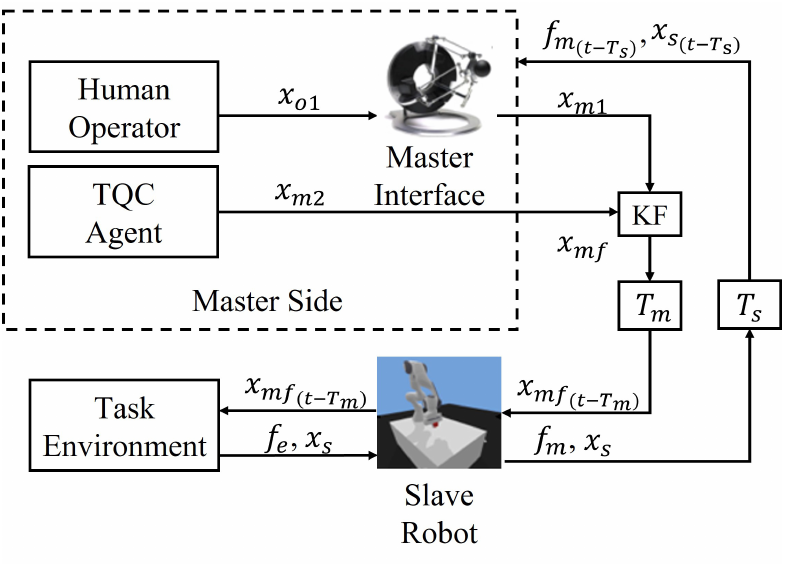
Figure 1. Overview of the human–agent cooperative teleoperation framework based on RL and KF.